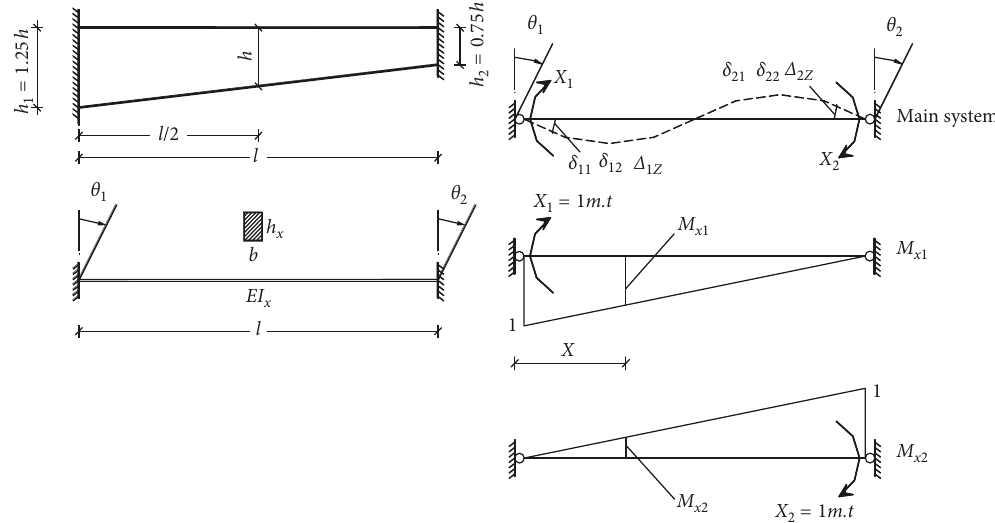
Figure 1: The proposed model for solving beam with variable